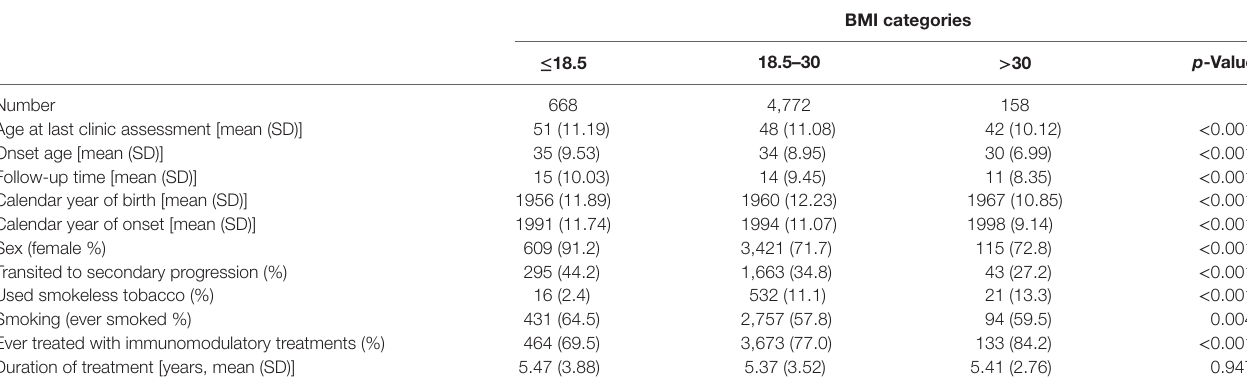
TaBle 1 | Basic clinical and demographic comparisons of patients in BMI